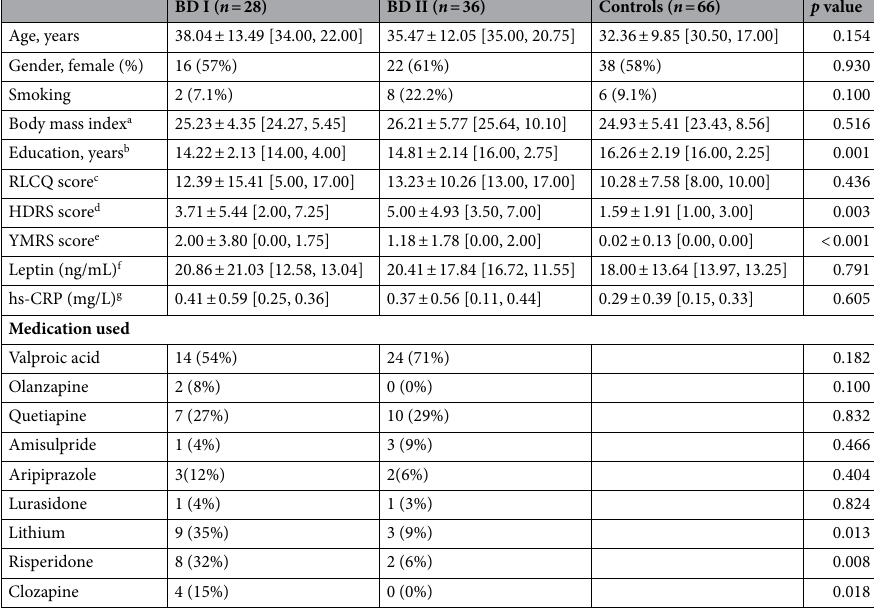
Table 1. Demographic data and baseline information. The data are presented as the means ± SD [median, interquartile range]. a Four BD I patients and 1 BD II patient without body mass index data were excluded from this calculation. b Five BD I patients and 4 controls without education level data were excluded from this calculation. c Five BD I patients, 1 BD II patient and 5 controls did not complete the Recent Life Change Questionnaire (RLCQ) and were excluded from this calculation. d Four BD I patients, 4 BD II patients and 5 controls did not complete the 17-item Hamilton Depression Rating Scale (HDRS) and were excluded from this calculation. e Four BD I patients, 2 BD II patients and 4 controls did not complete the 11-item Young Mania Rating Scale (YMRS) and were excluded from this calculation. f Five BD I patients, 2 BD II patients and 12 controls did not undergo plasma leptin level measurement and were excluded from this calculation. g Four BD I patients, 2 BD II patients and 3 controls did not undergo plasma CRP level measurement and were excluded from this